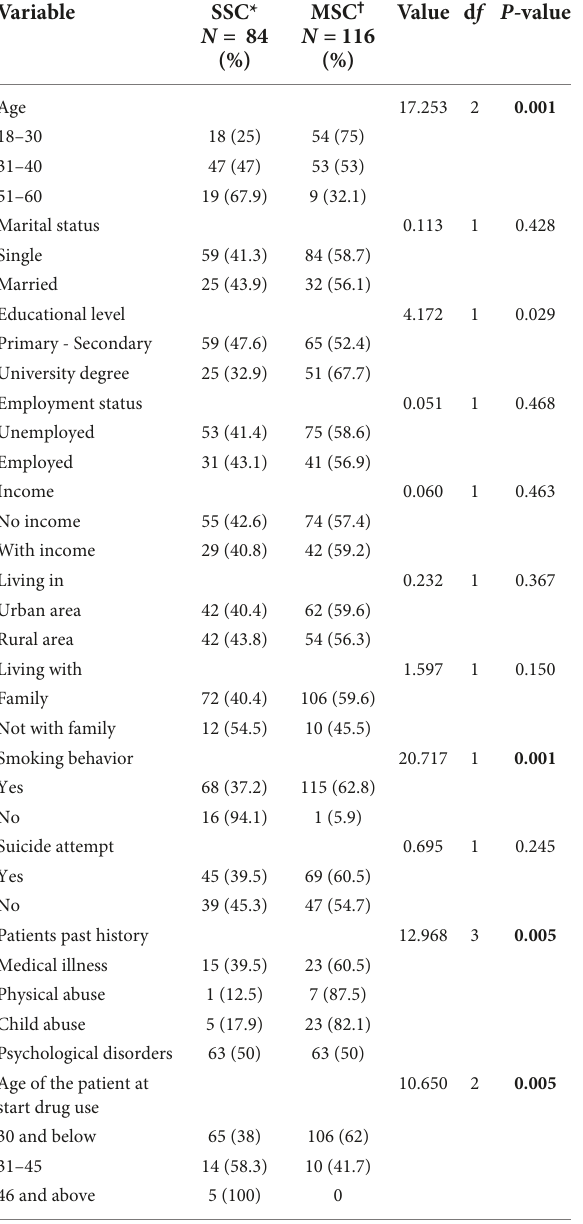
TABLE 4 Difference between single and multiple substance use of the participants in relation to their sociodemographic characteristics.